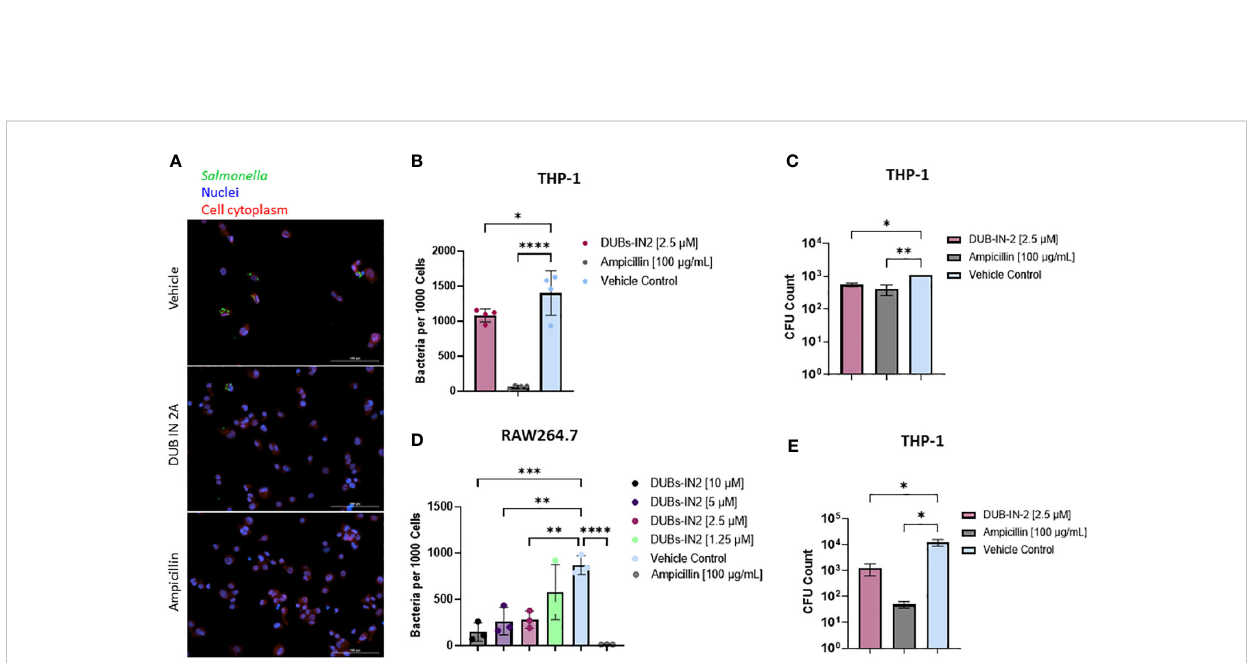
FIGURE 4 Impact of USP8 inhibition on intracellular Salmonella growth. (A-C) . Effect of USP8 inhibition on the level of intracellular bacteria in macrophages. (A, B) THP-1 macrophages were infected with GFP-expressing Salmonella at 24 hours after treatment with vehicle control, 2.5 m M DUB IN 2A, or 100 m g/mL ampicillin THP-1 nuclei and cytoplasm were stained using DPAI and HCS Cell Mask, respectively, and were imaged on the Cytation5 imaging platform (A) . Host cells, nuclei as well as GFP-tagged intracellular bacteria were visualized using fl uorescent microscopy (Cytation 5), followed by counting of the GFP-tagged intracellular bacteria within the cell mask and host nuclei (n=3). Intracellular bacteria per 1000 cells is shown (B) . Signi fi cance was determined using a one-way ANOVA. Ampicillin was used as control, and vehicle control (VC) containing DMSO. The number of independent replicates for this experiment was 4 (n=4). (C) RAW264.7 macrophages were infected with GFP- Salmonella for 2 hours. Following this infection, cells were treated with 10, 5, 2.5, or 1.25 µM DUBs-IN2 USP8 inhibitor or 100 m g/mL ampicillin for 24 hours. Similar analysis of intracellular bacteria was done as in (B) . The number of independent replicates for this experiment was 3 (n=3). (D, E). THP-1 macrophages were infected with wild-type Salmonella Typhimurium for 1 hour followed by an additional hour incubation with 100 m g/mL of gentamicin to remove extracellular bacteria. Following this infection, cells were treated with 2.5 m M DUBs-IN2 USP8 inhibitor or 100 m g/mL ampicillin for either a 2- (D) or 24-hour (E) period. After these time points, the cells were lysed using 0.1% Triton-X100 with cell lysates being serially diluted to 10 -6 and spot plated on LB Miller agar plates and incubated overnight at 37°C. CFU counts were taken for each treatment condition. The number of independent replicates for this experiment was 4 (n=4). P-values were indicated as follows: * p ≤ 0.05; ** p ≤ 0.01; *** p ≤ 0.001; **** p ≤